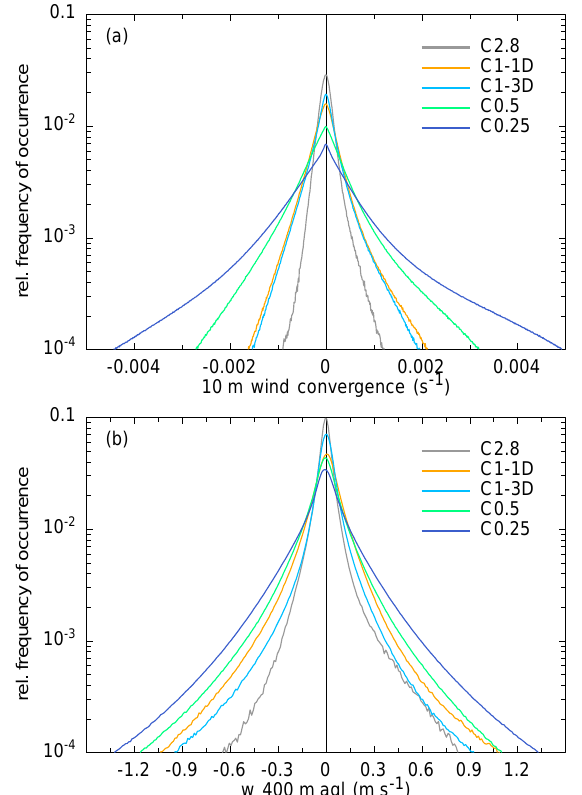
Figure 12. Probability density functions of the 10m wind conver- gence (a) and vertical velocity at ∼ 400ma . g . l . (b) on 23 July